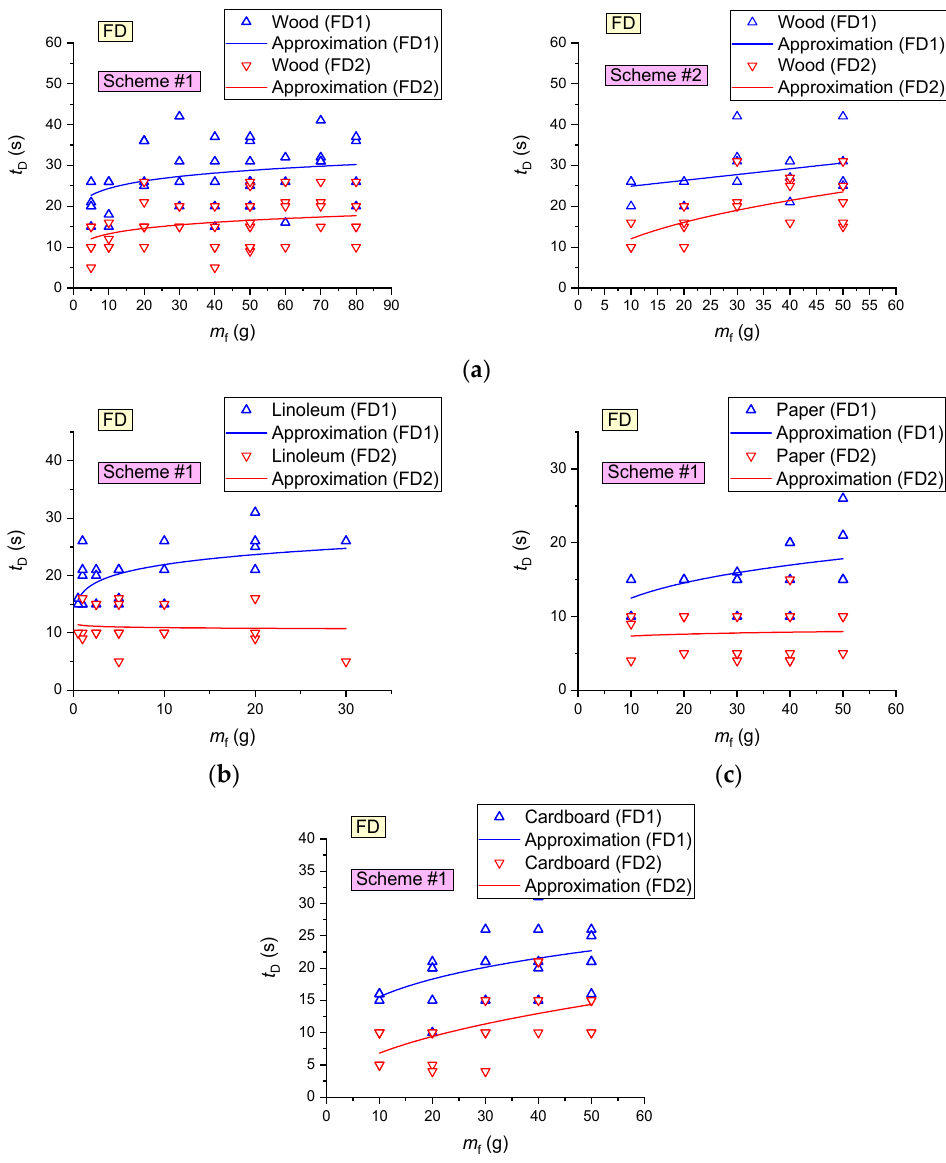
Figure 12. FD activation delay times versus the sample mass during the combustion of wood ( a ), linoleum ( b ), paper ( c ) and cardboard ( d ).